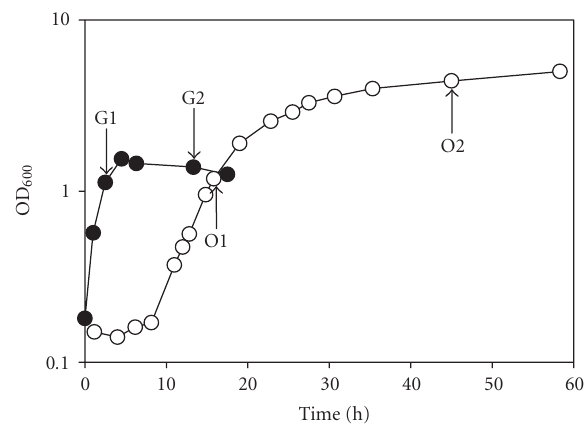
Figure 1: Time profiles of the concentrations of E. coli cells. The cell densities (OD 600 ) of E. coli W3110 in the presence of glucose ( • ) or oleic acid ( ◦ ) are shown. Gl, G2, O1, and O2 are the sampling points for proteome